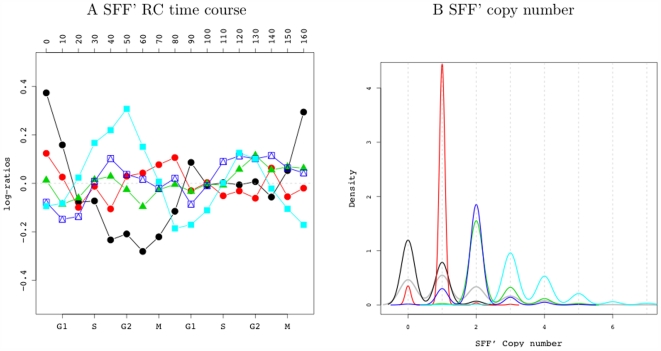
Time courses and dosages of SFF' for the multiple SFF' RCs in cell cycle.Panel A depicts SFF' RC's time profiles with different RCs differentiated by the different colors and their corresponding SFF' dosages are illustrated in B.